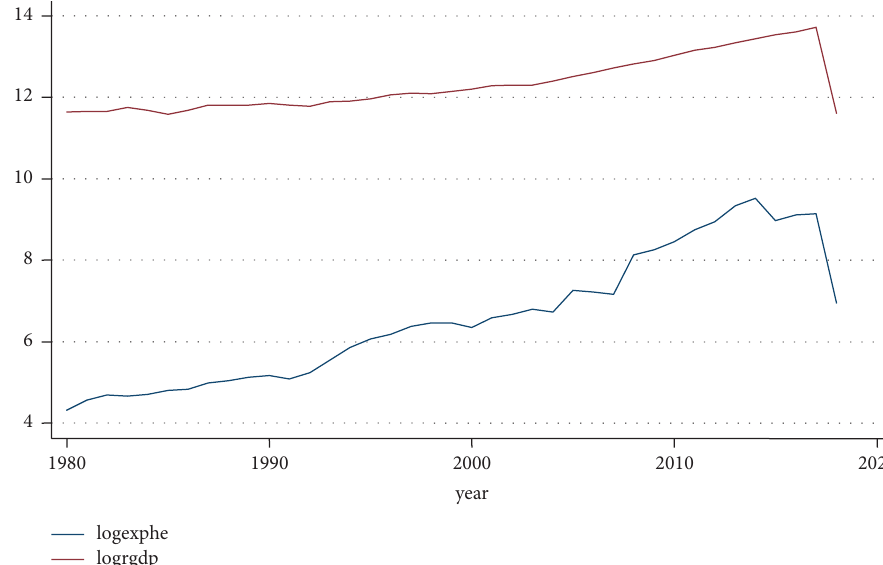
Figure 4: Trend of health expenditure and RGDP. Source: own computation based on the data from MOFED and National Bank, 2022.